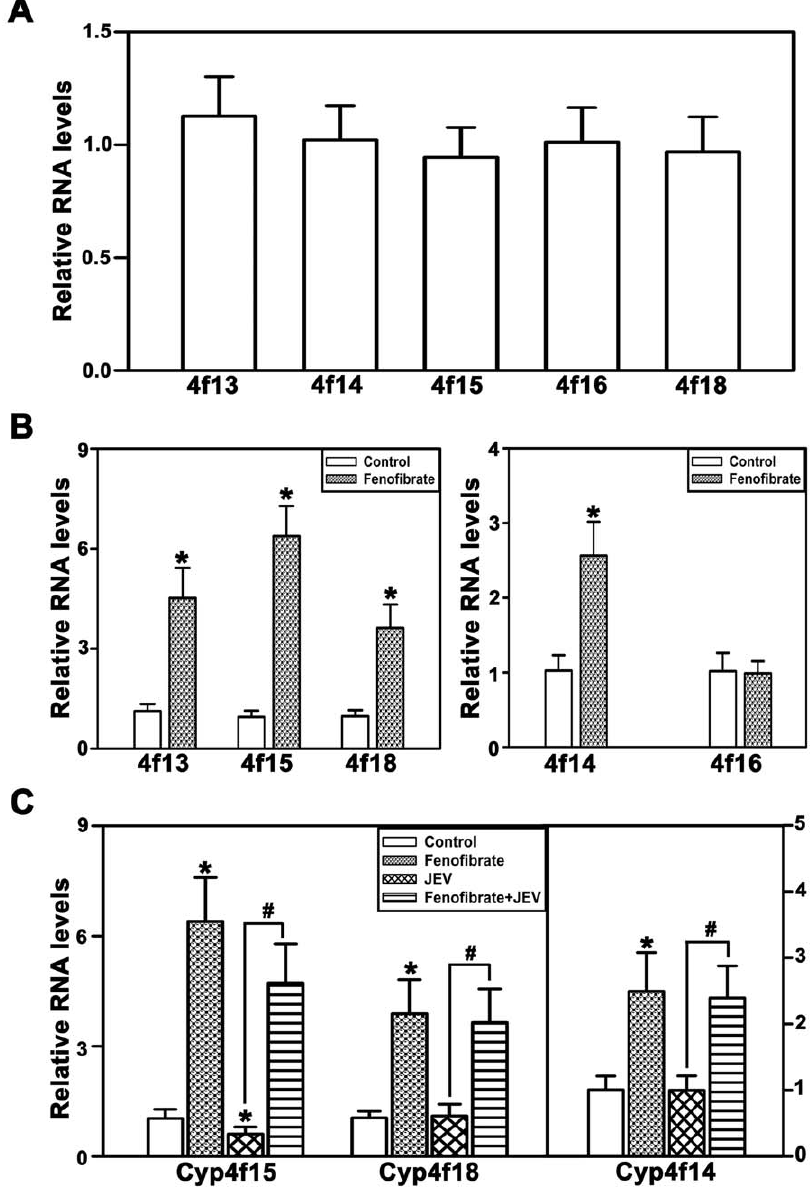
Figure 2. Induction of Cyp4fs by fenofibrate, in vitro, in BV-2 cells. (A) Constitutive expression of Cyp4fs in BV-2 cells. mRNA levels of all Cyp4fs are expressed relative to Cyp4f15. (B) Fenofibrate induced the expression of Cyp4f13, 14, 15 and 18, however the levels of Cyp4f16 were unaltered. (C) There was a significant decrease in the expression of Cyp4f15 following JEV infection. The levels of Cyp4f14 and 18 were unchanged. Pretreatment with fenofibrate however, attenuated JEV mediated inhibition of Cyp4f15. The mRNA levels in B, C are expressed relative to controls (n=6 per group, *and # p , 0.05).